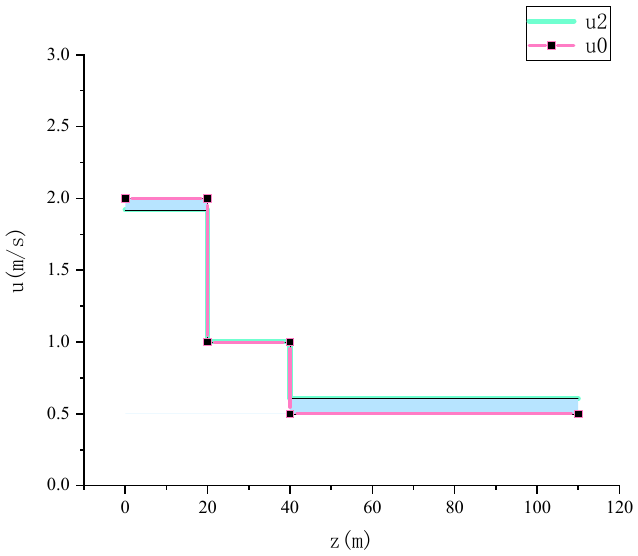
Figure 12. CNN to obtain the velocity compared with the real value under disturbance.